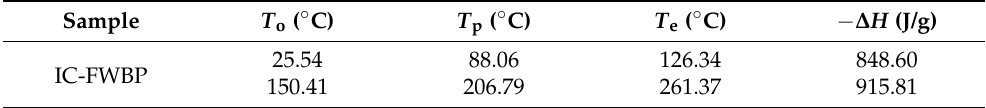
Figure 7. Thermogravimetry and derivative thermogravimetry curves of IC-FWBP. Table 4. The DSC results of IC-FWBP.